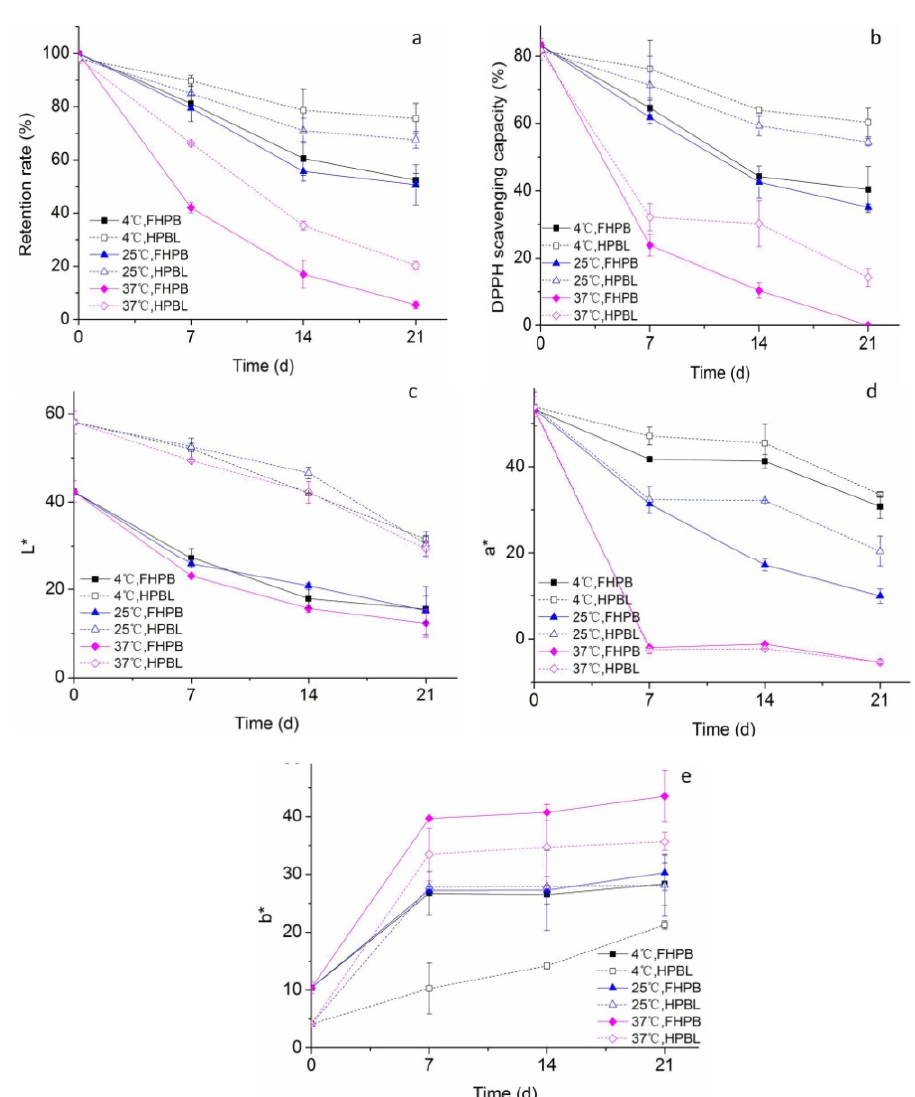
Figure 3. Stability of HPBL under different storage temperatures: ( a ) Retention rate; ( b ) DPPH scavenging activity; ( c ) L * value, which represents the color of lightness; ( d ) a * value, which represents the color redness when the value is positive; and ( e ) b * value, which represents the color of yellowness when the value is positive.